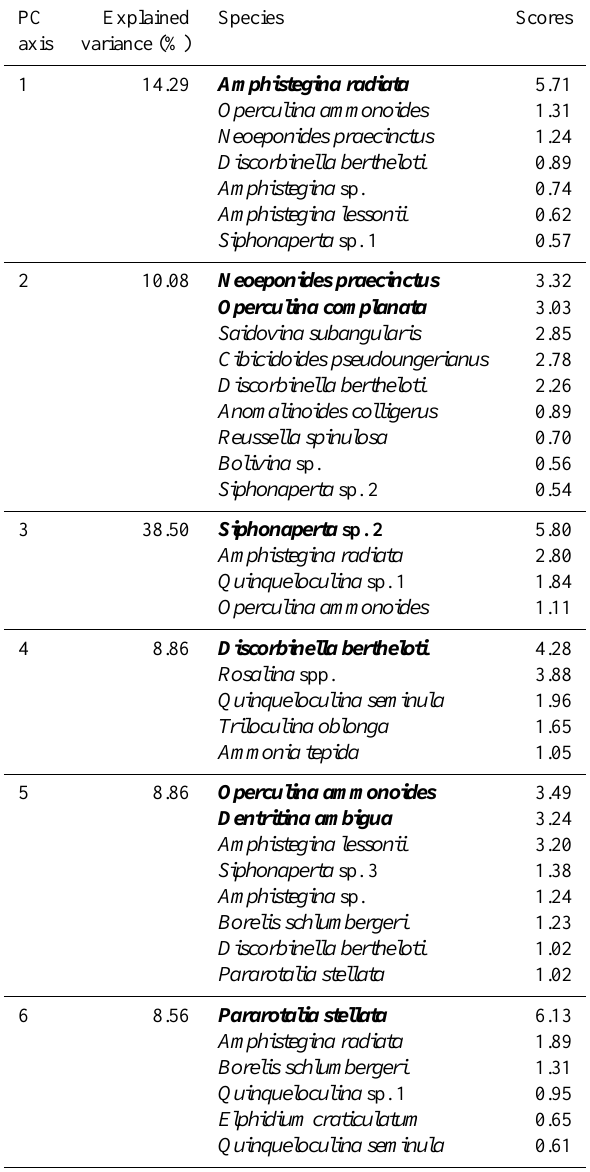
Table 2. Results of the principal component analysis (see also Fig. 4) with the total variance explained by each principal compo- nent (PC) and the scores of the most important species. The species in bold, having the highest scores, are eponymous for the assem- blages extracted from the surface